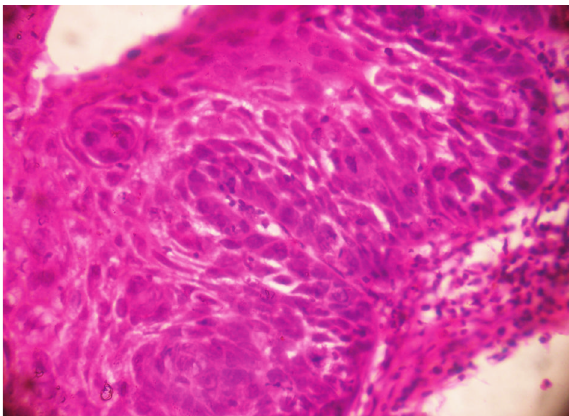
Figure 2: Dysplastic features such as basal cell hyperplasia, nuclear and cellular pleomorphism, and nuclear hyperchromatism at 400x.